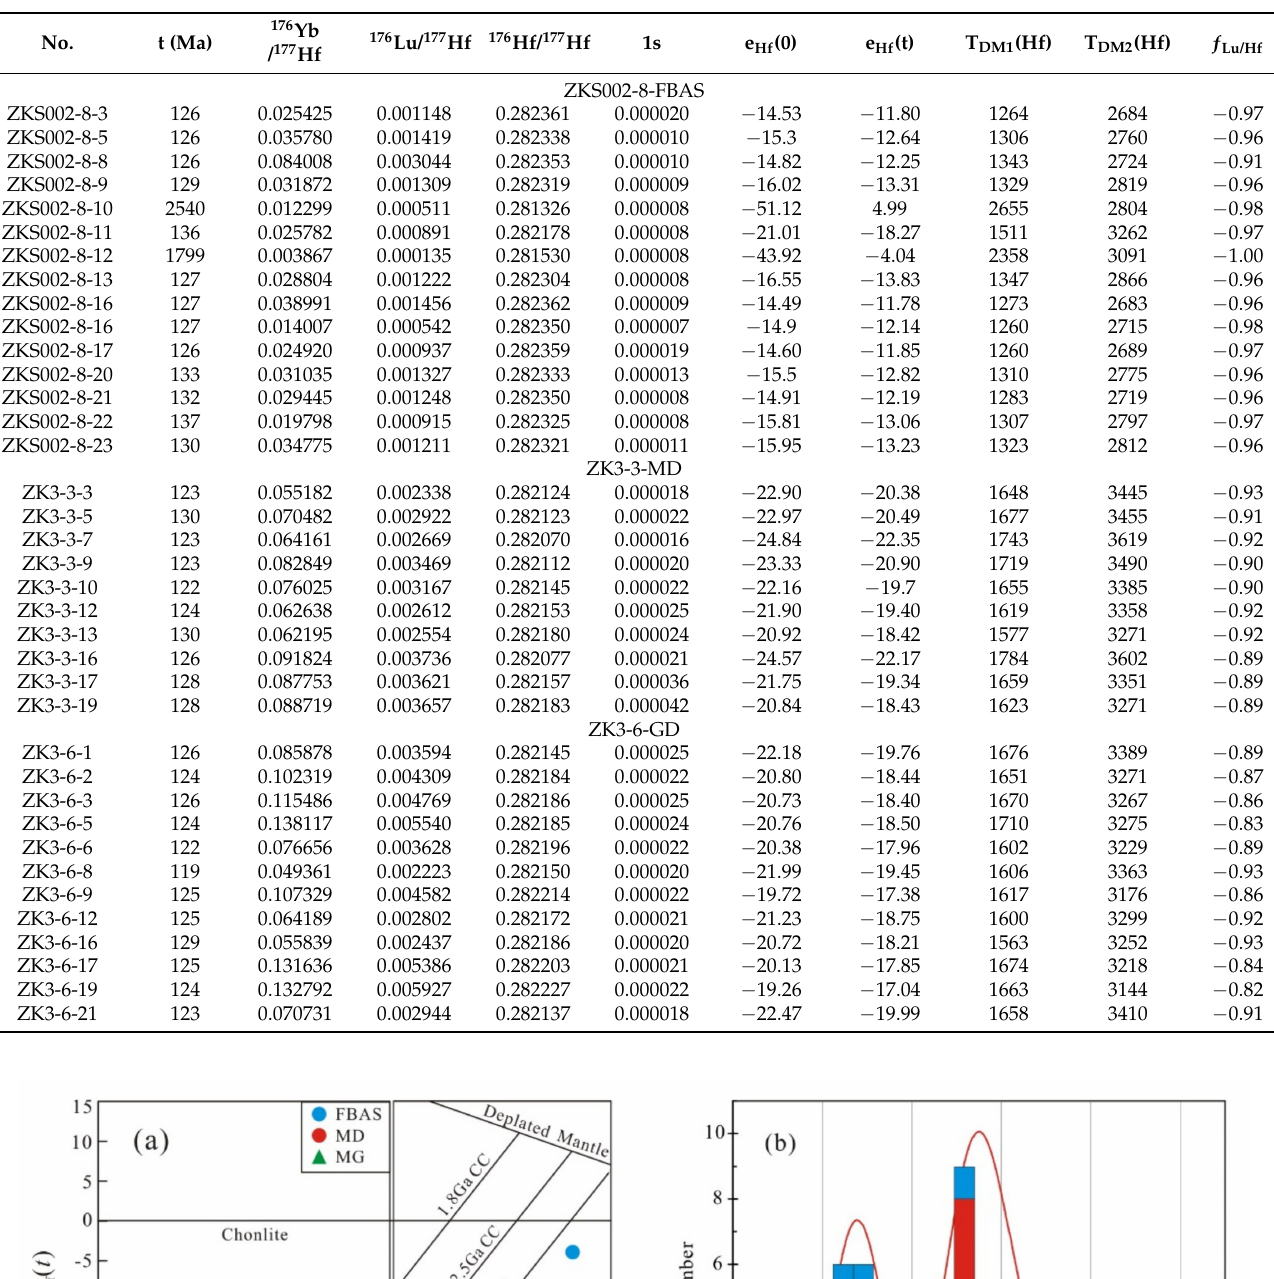
Table 3. In situ zircon Hf isotopic compositions for the Hongshan complex.